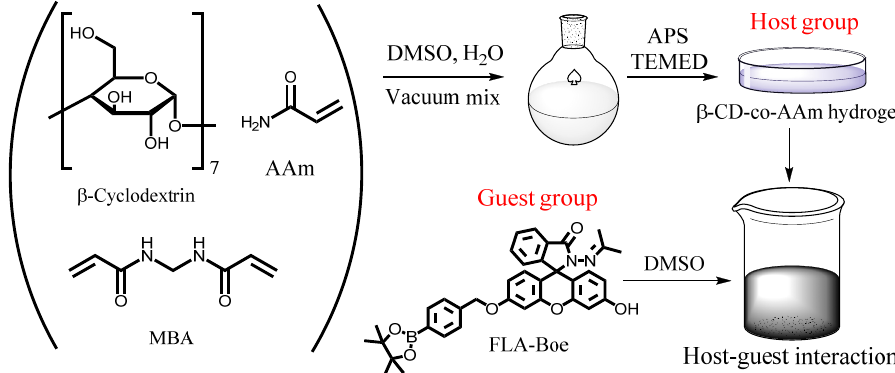
Figure 1. Synthesis diagram of the hydrogel sensor.